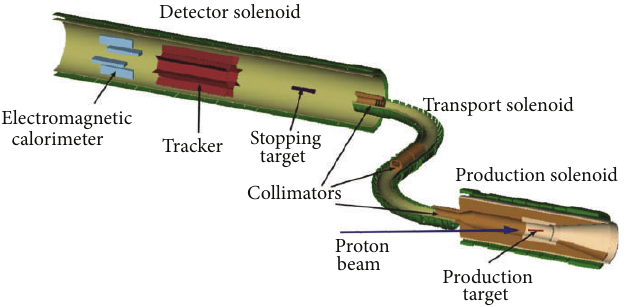
Figure 25: Layout of the Mu2E experiment.